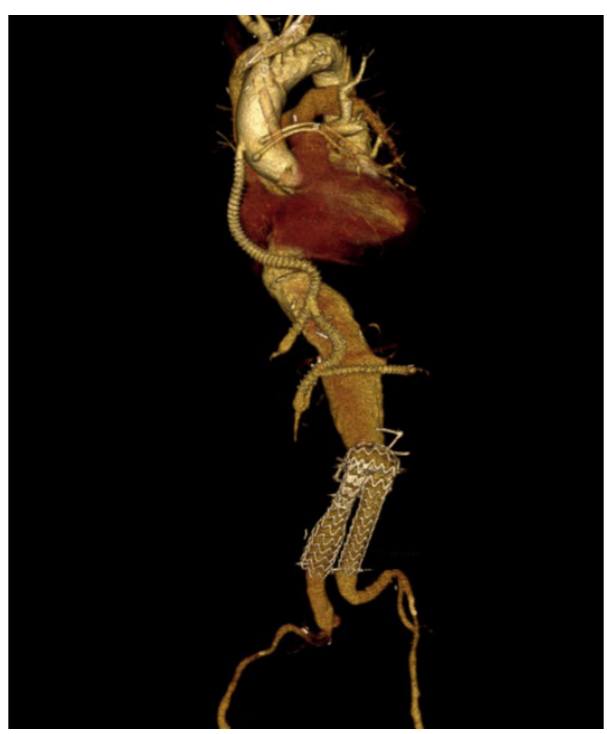
Fig. 3 - Preoperative computed tomography angiography of giant thoracoabdominal dissecting aneurysm in the patient with Marfan